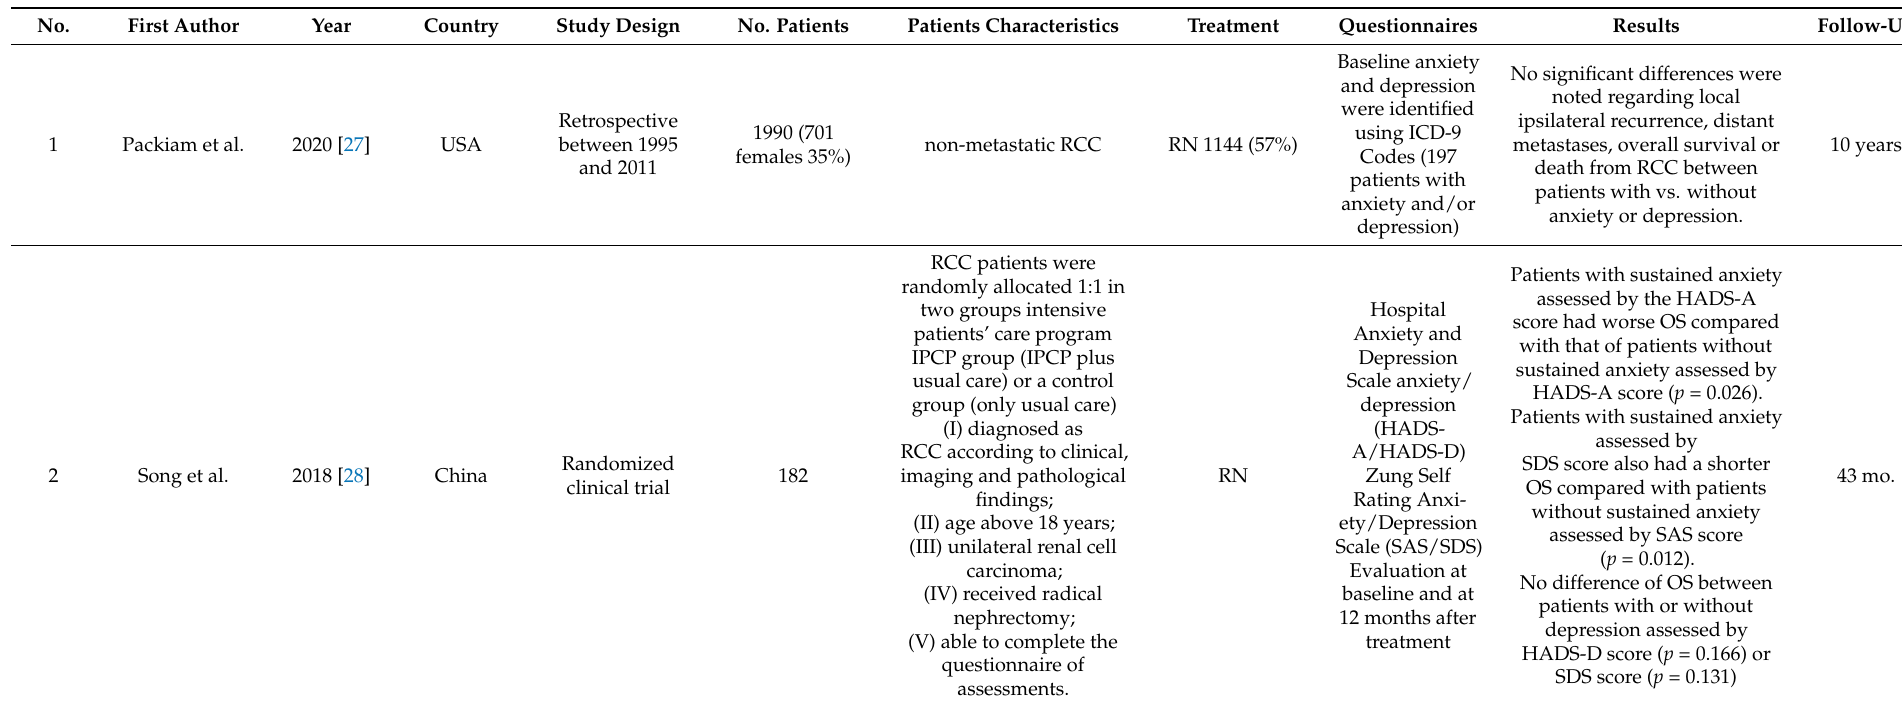
Table 2. Studies that assessed the impact of anxiety or depression on oncological outcomes of patients with non-metastatic renal cell carcinoma